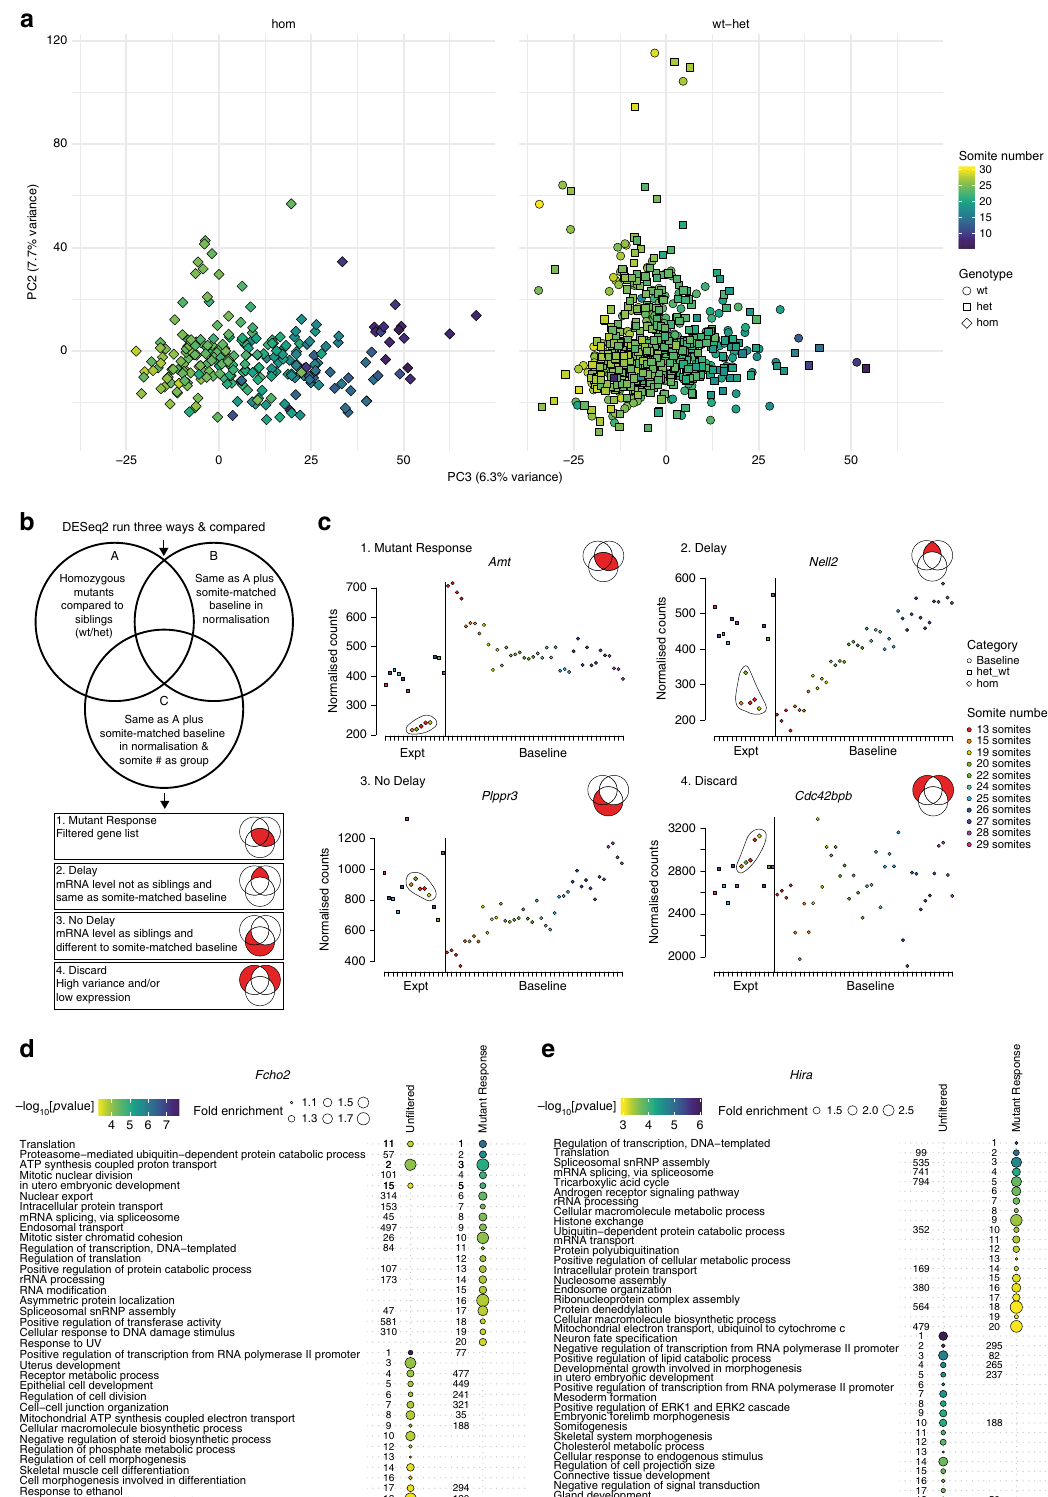
hypoxia ” (GO:0001666) which might re fl ect stress or placental defects 17 . Although generally the enriched terms differed between lines, small groups of lines that shared similar sets of enriched terms were found (Fig. 5a). One group of mutants in which similar sets of terms were enriched contained genes previously implicated